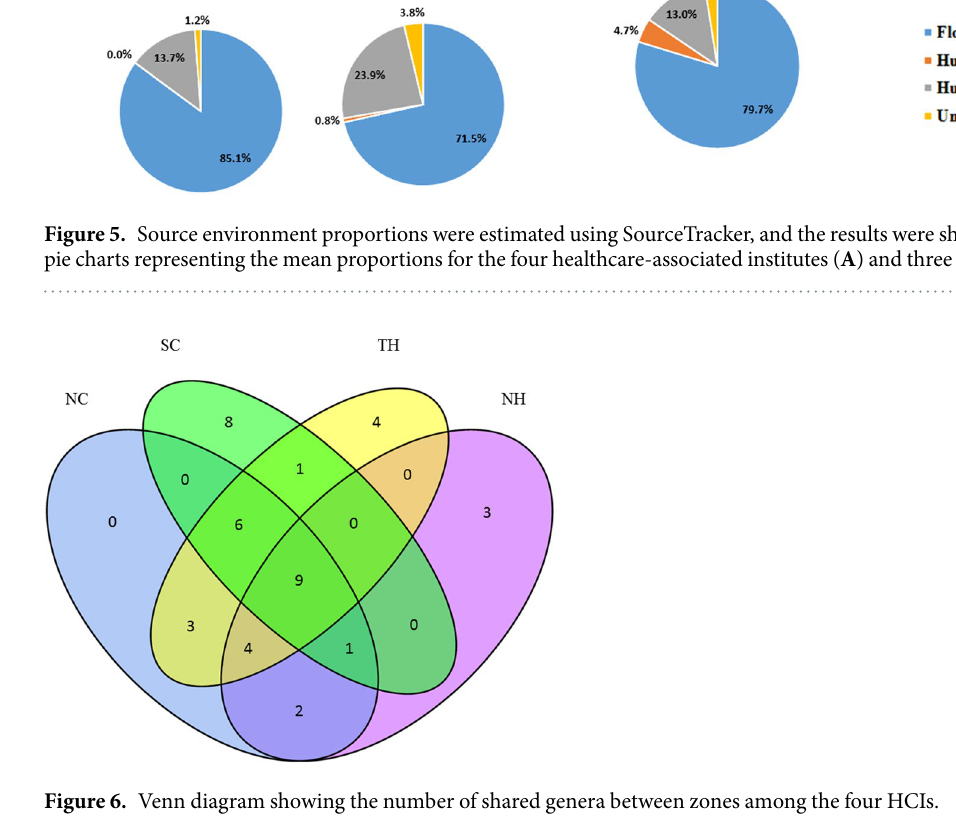
Figure 6. Venn diagram showing the number of shared genera between zones among the four HCIs.